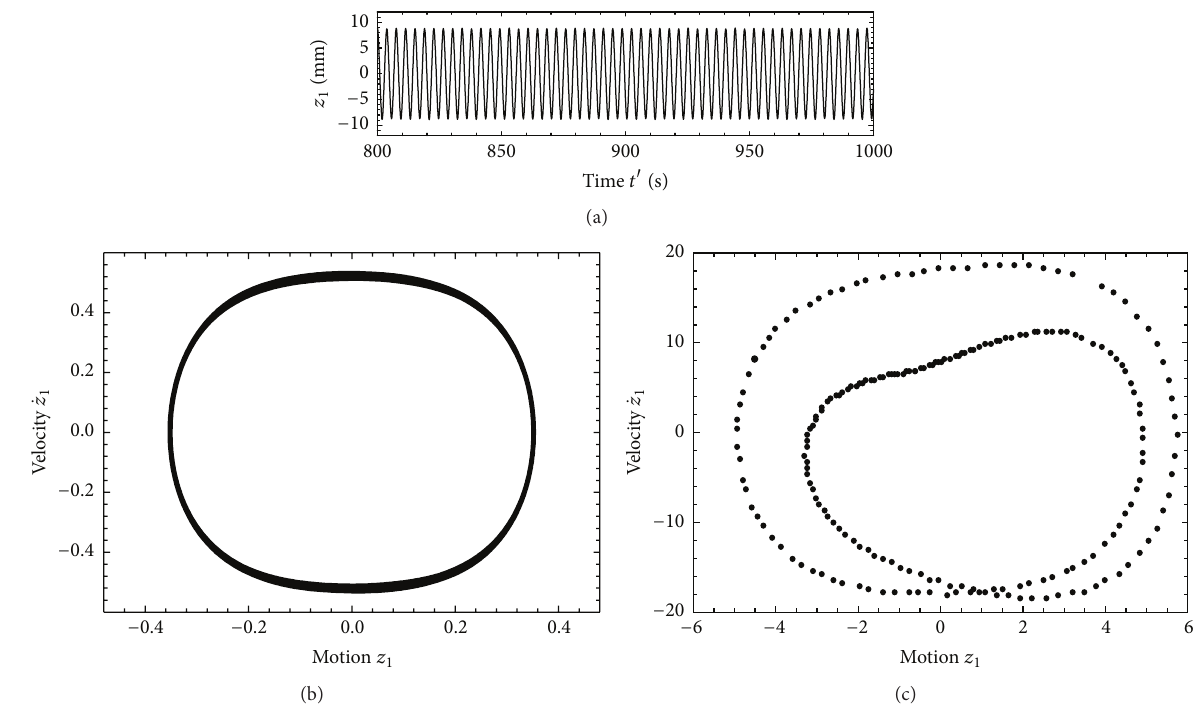
Figure 11: The time series and Poincare mapping section for 𝜏 = 3.5 and 𝜔 = 154 rad/s: (a) time series; (b) the phase diagram; (c) the Poincare mapping